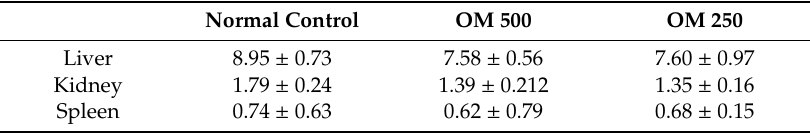
Table 1. E ff ect of sub-acute administration of OM on the relative weight of organs. Table 1. Effect of sub-acute administration of OM on the relative weight of organs.